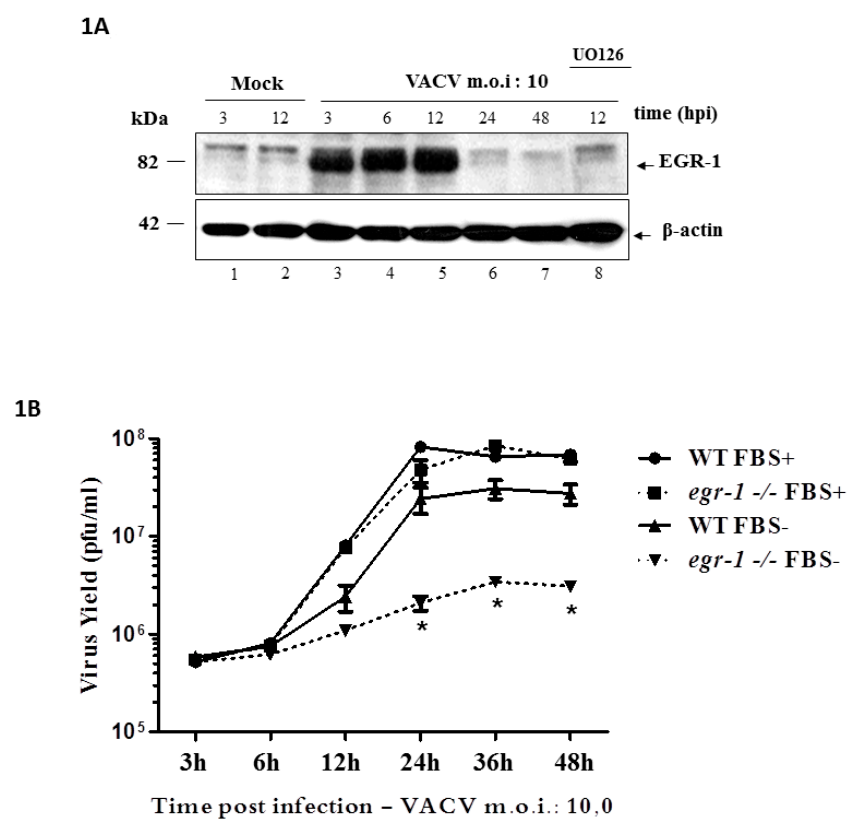
Figure 1. Expression of early growth response-1 EGR-1 protein during Vaccina virus (VACV) infection and effects of its deletion in viral replication. ( A ) VACV infection stimulates EGR-1 expression through the MEK (mitogen-activated protein kinase (MAPK)/ERK)/ERK (extracellular signal- regulated kinases) pathway with similar patterns—Western blotting analysis of VACV-infected wild type (WT) mouse embryonic fibroblasts (MEFs) at a multiplicity of infection (MOI) of 10 for the times indicated. Cells were starved with 0.1% fetal bovine serum (FBS) for 12 h and then were either Mock- infected or infected with VACV (lanes 3–8). Where indicated, cells were incubated for 30 min with the MEK inhibitor U0126 (15 µM) prior to and throughout the course of infection (lane 8). The molecular masses are indicated (KDa) on the left. ( B ) VACV growth curve performed with MEFs WT and egr- 1 − / − —Cells were infected with VACV at an MOI of 10 for 3, 6, 12, 24, 36 or 48 h. Infection occurred in